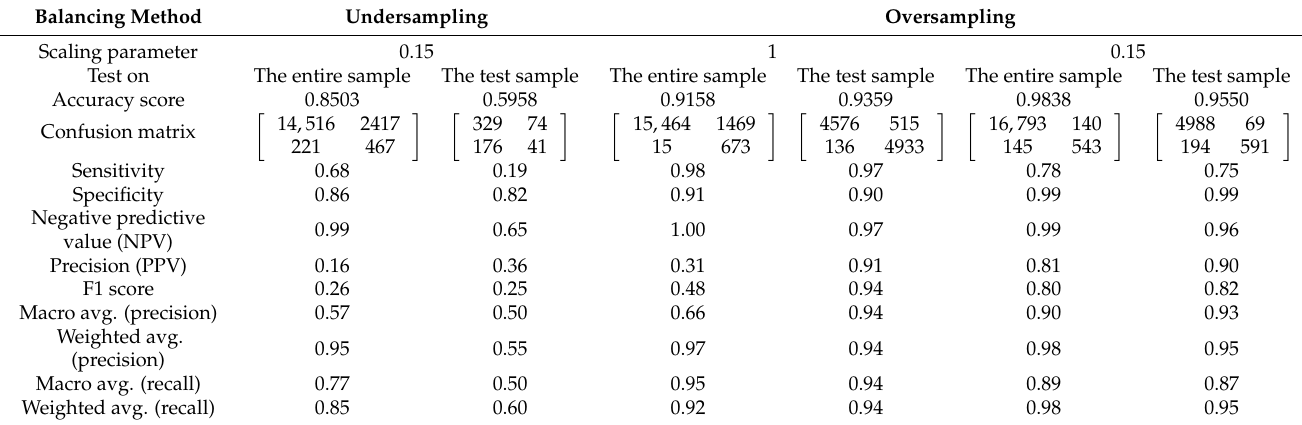
Table 2. Comparison of different balancing methods and their impact on the results obtained by the random forest model. Balancing Method Undersampling Oversampling Scaling parameter 0.15 1 0.15 Test on The entire sample The test sample The entire sample The test sample The entire sample The test sample Accuracy